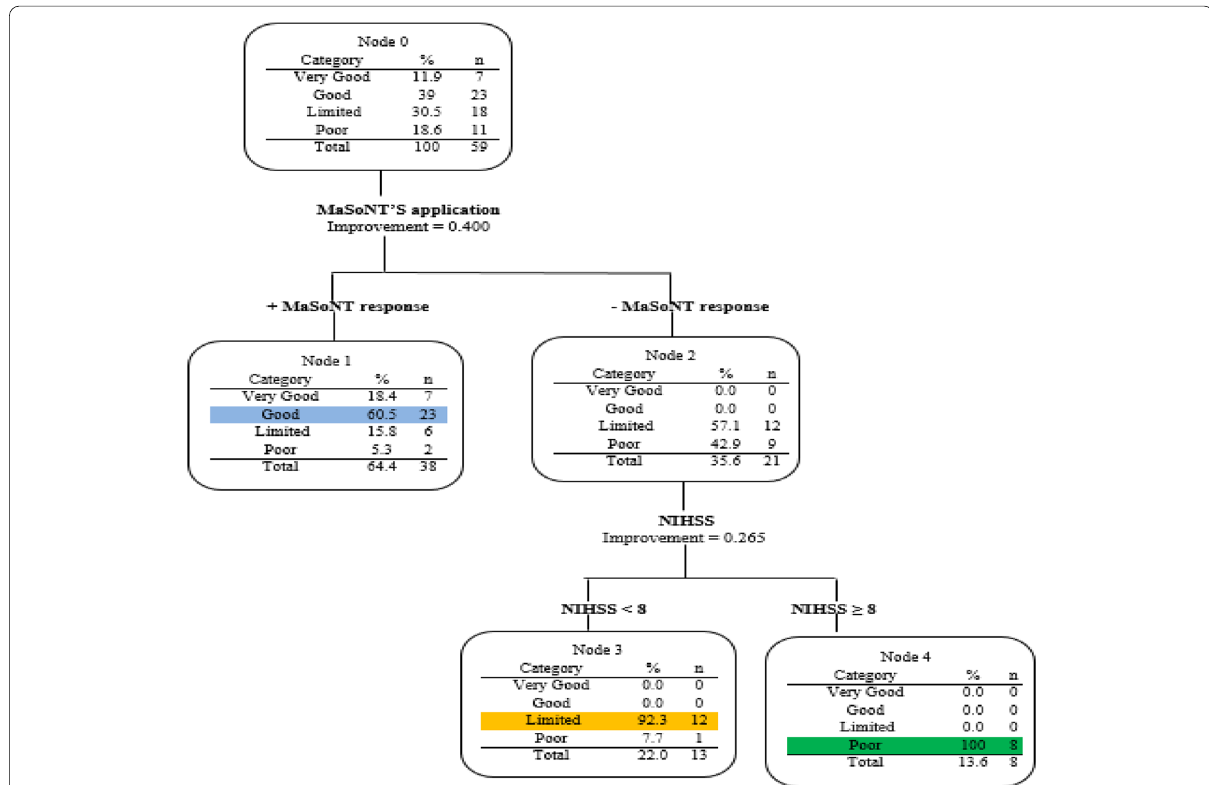
Fig. 3 CART analysis for patients who had SAFE score under 8 at day 3 after stroke. range of motion that is elicited by applying the basic upper-limb technique.